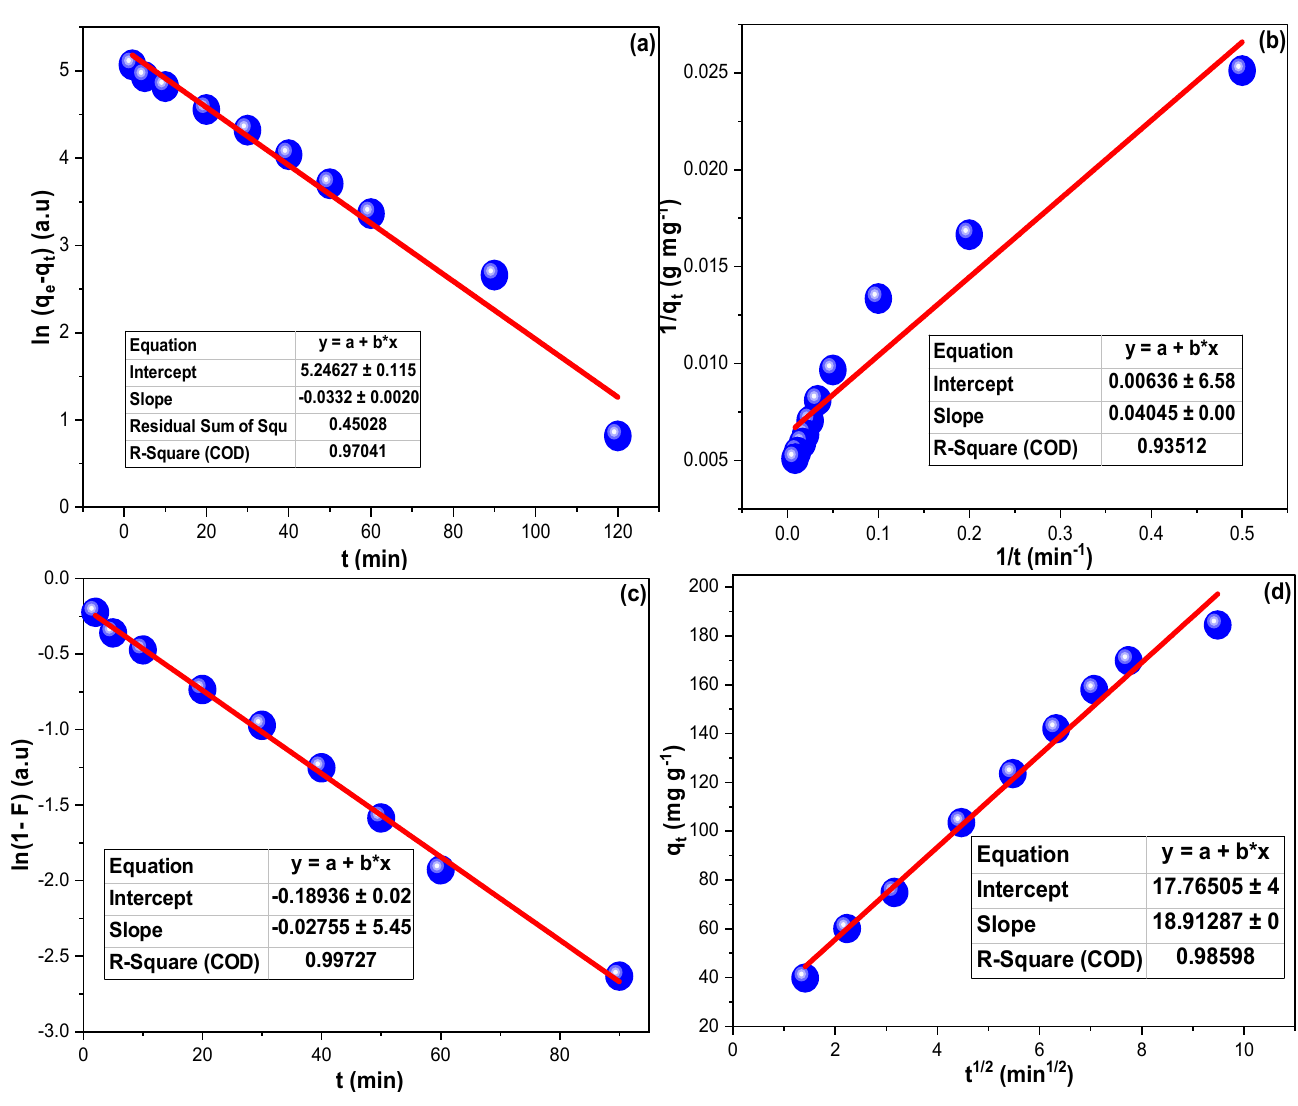
Figure 8. Kinetic investigations for the removal of IGC by the Al 2 O 3 -NiO nanocomposite, including ( a ) FOM, ( b ) SOM, ( c ) LDM, and ( d ) IM.